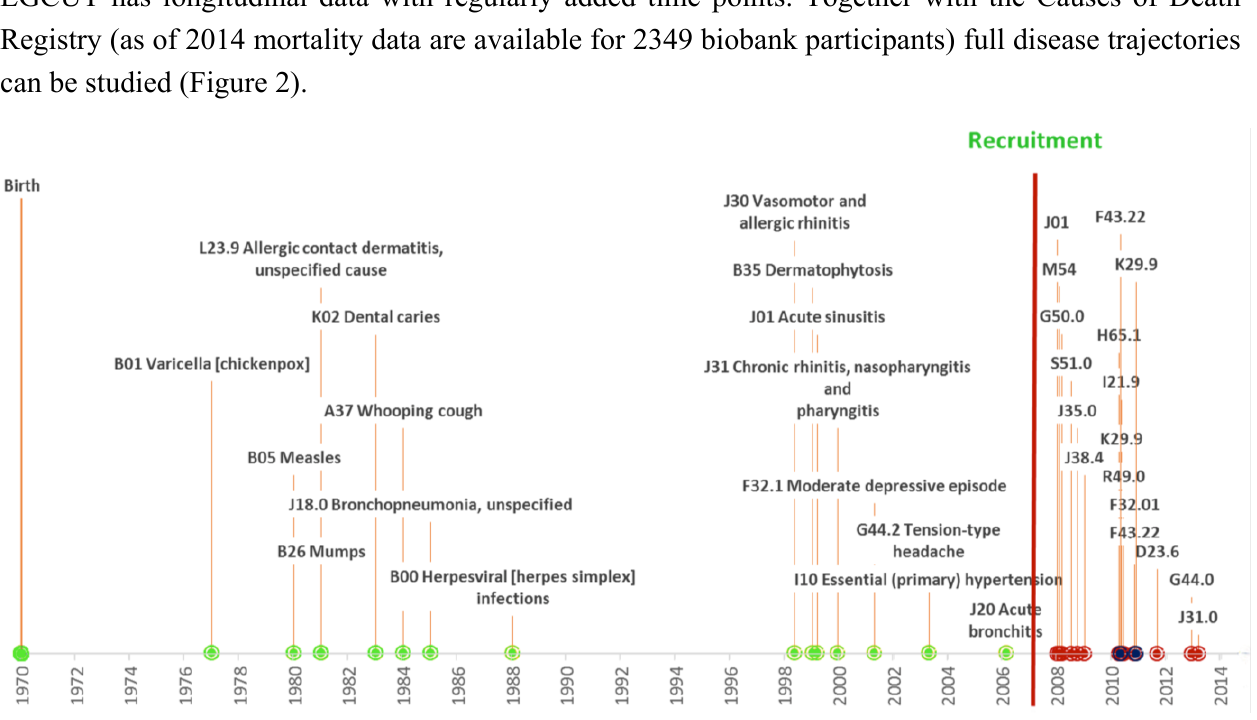
Figure 2. An individuals’ disease trajectory. A participant born in 1970 and recruited in 2007. Different data sources or collection methods are color coded; green—information gathered at the baseline interview, red—retrieved from Health Insurance Fund database, and blue—retrieved from the Northern Estonian Medical Center. The health status updates coded according to the